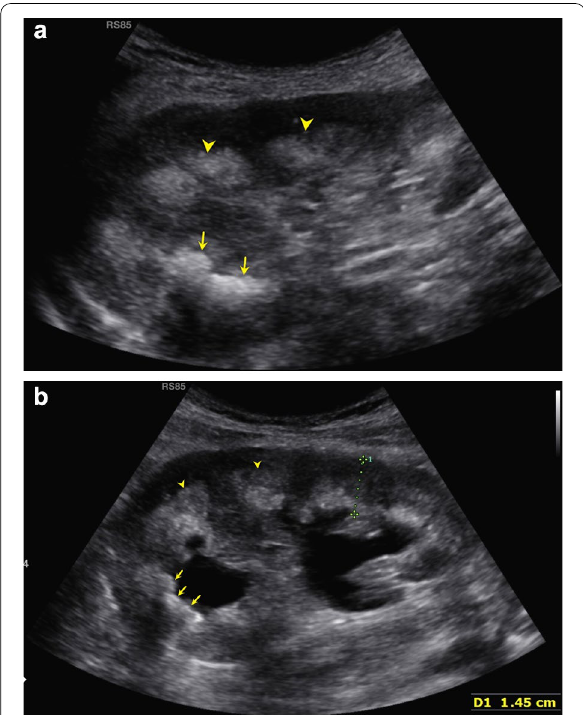
Fig. 1 Philips EPIQ, convex transductor, B-mode, frequency 2,5–5 MHz, right lower abdomen quadrant. a The caudal kidney shows a hypoechoic cortical with hyperechoic medulla (arrowheads). The superior calyceal group presents even large kidney stones with the typical rear shadow cone behind (arrows). b The cranial kidney shows the same echographics characteristics of the caudal kidney: a hypoechoic cortical with hyperechoic medulla (arrowheads), and kidney stones with rear shadow cone (arrows). Moreover, we can appreciate the dilatation of renal pelvis probably due to bladder replenish or urethral stones. Renal parenchymal thickness (among calipers) is normal suggesting a preserved renal parenchyma. Both kidneys present the same sonography pattern, consistent